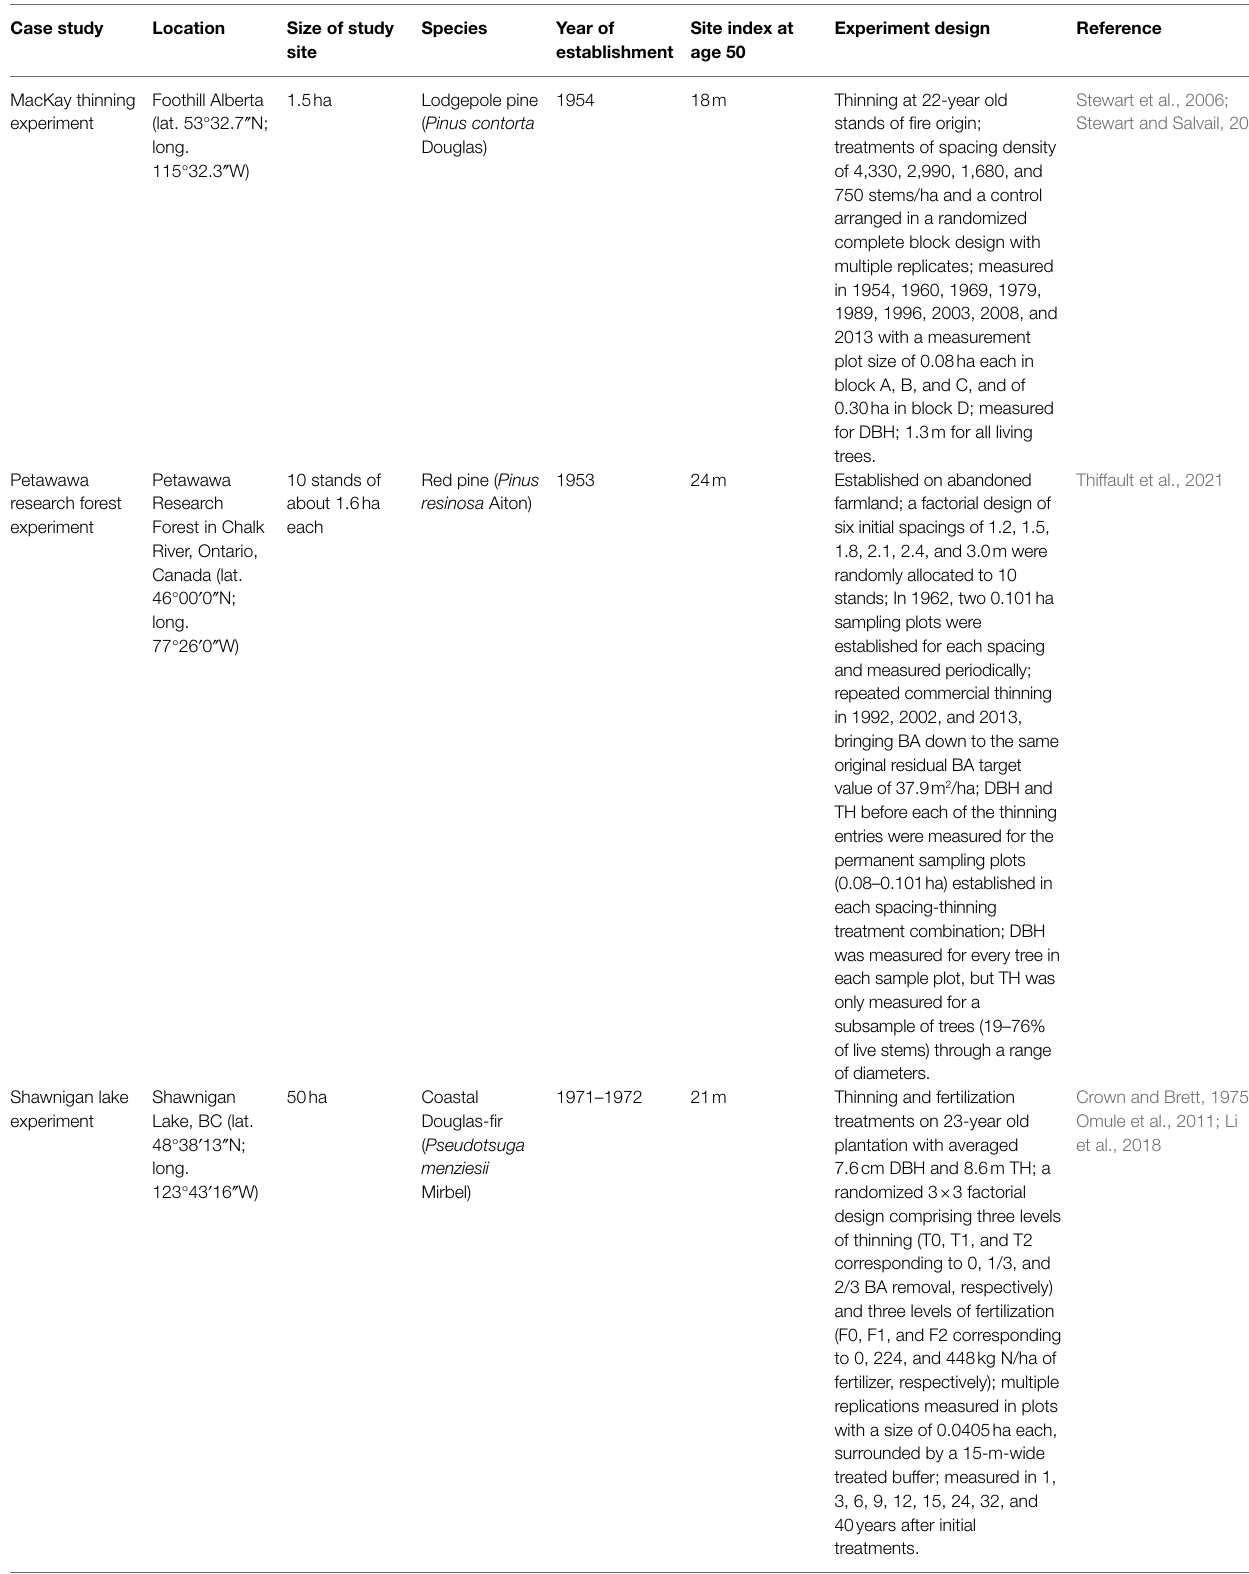
TABLE 1 | Summary of the three case studies in Canada. Case